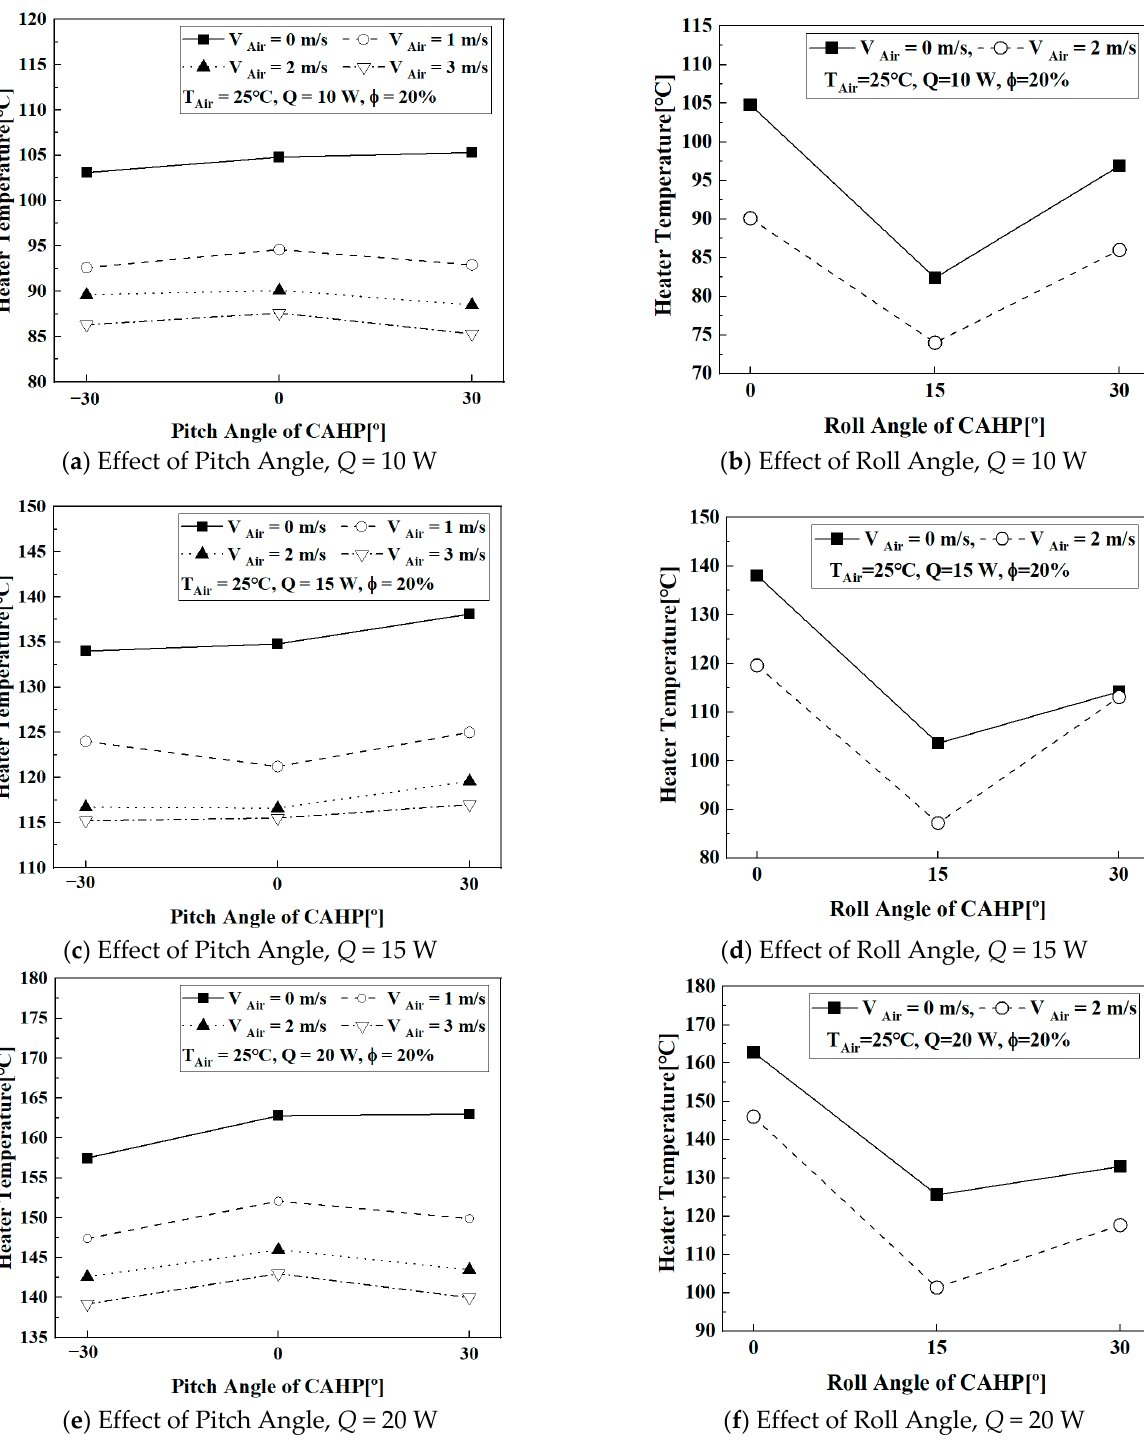
Figure 8 . Heater temperature according to Q , V air , pitch angle, and roll angle ( ∅ = 20%). Figure 8. Heater temperature according to Q , V air , pitch angle, and roll angle ( ∅ =